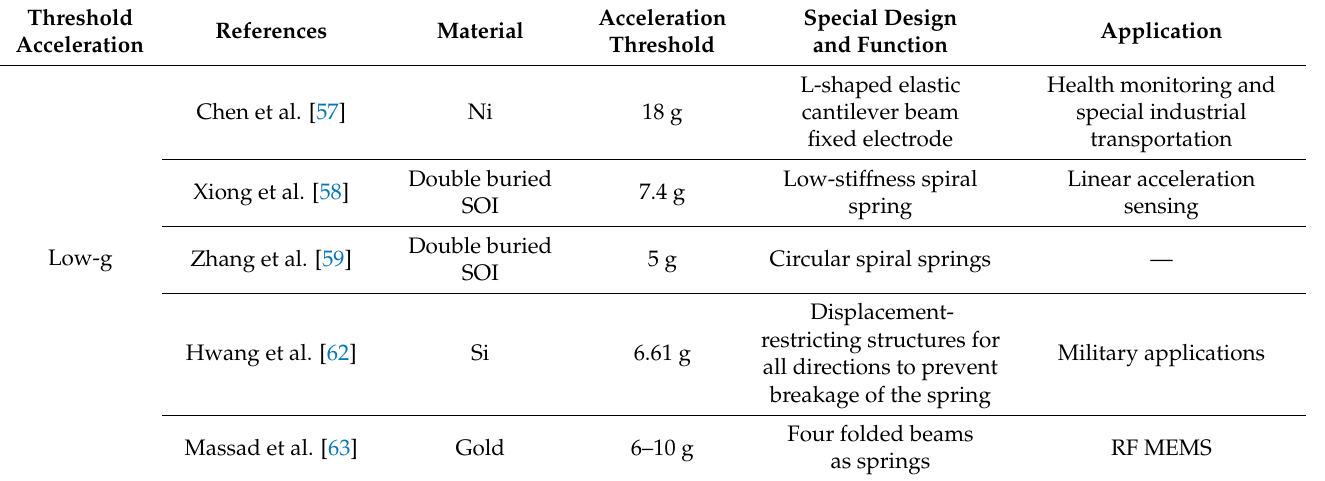
Figure 7. Simplified schematic view of a 3-bit digitally operated MEMS switch. Table 2. A summary of some examples of typical threshold acceleration inertial switch